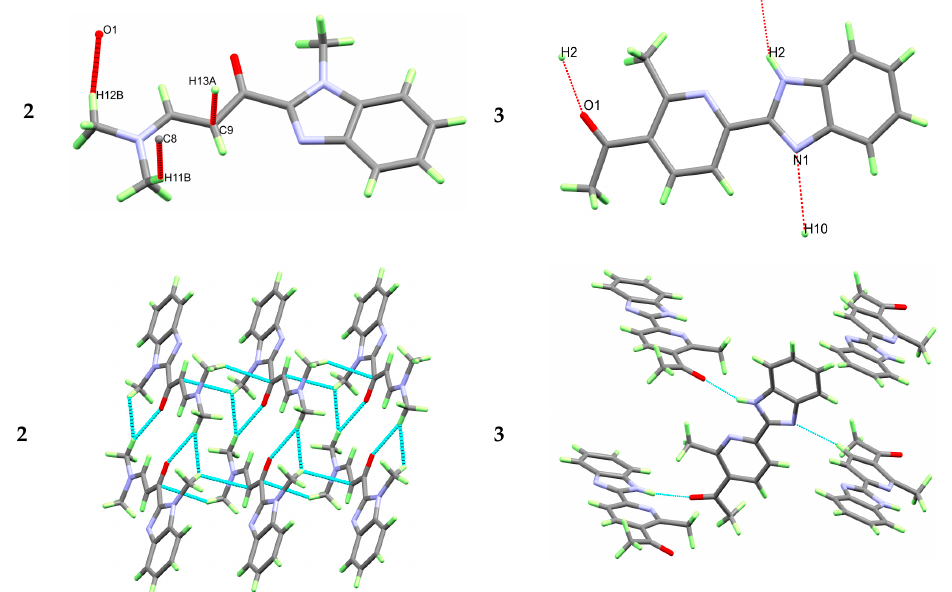
/ left) and molecular packing (lower / left) of 2 . Figure 2. Intermolecular contacts (upper/left) and molecular packing (lower/left) of 2 . H-bond: C12- Figure 2. Intermolecular contacts (upper